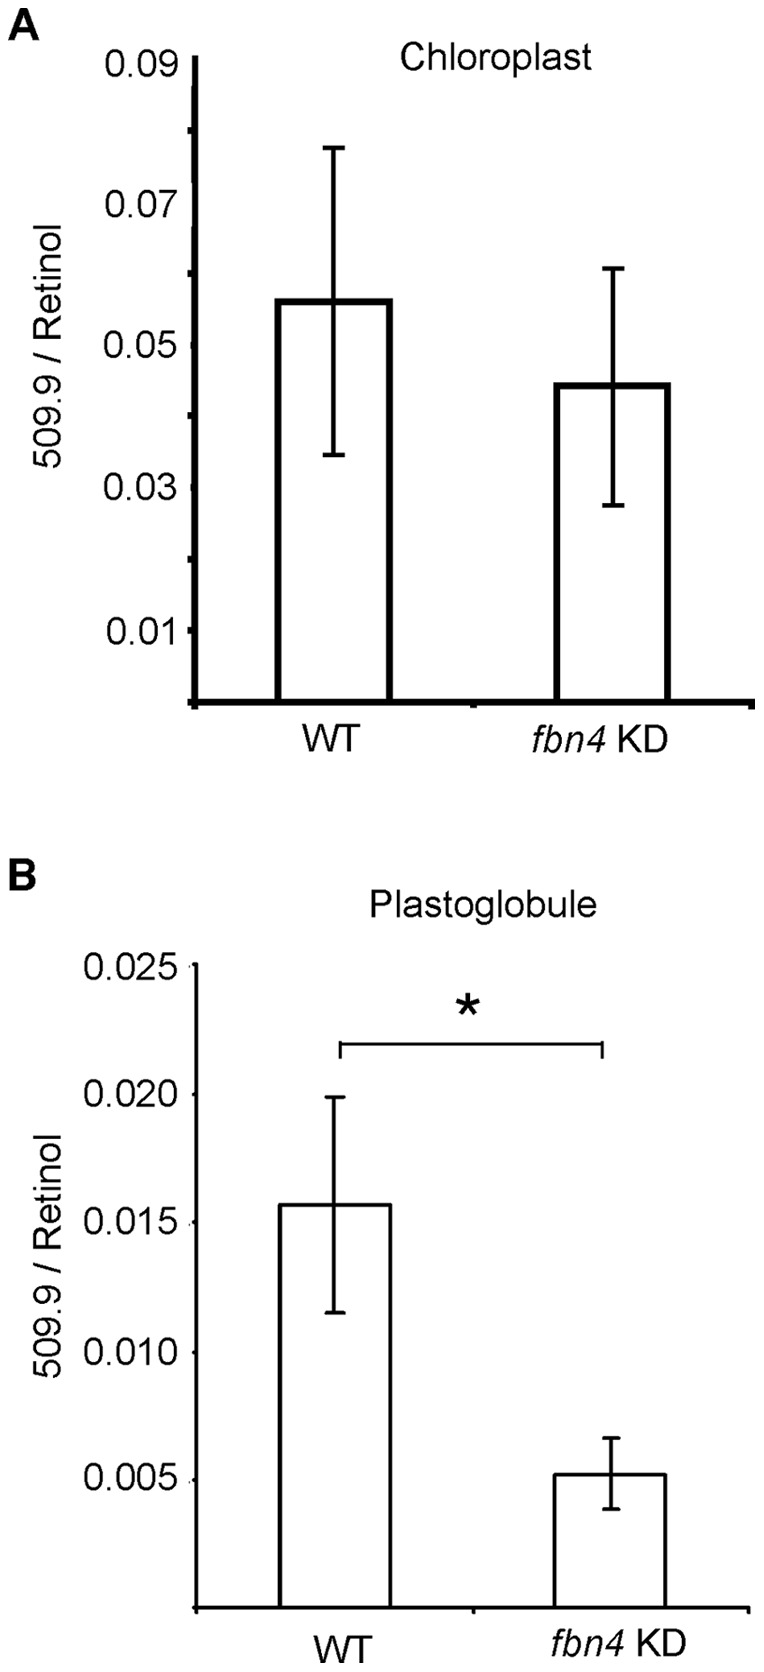
Analyte at m/z 510.Abundance in WT and fbn4 KD lipid extracts from chloroplasts (B) and plastoglobules (C), normalized to retinol. Data are means ± SD of three measurements; *, P<0.05 using Student's t test. Similar results were obtained in two biological replicates for the chloroplasts and three biological replicates for the plastoglobules.